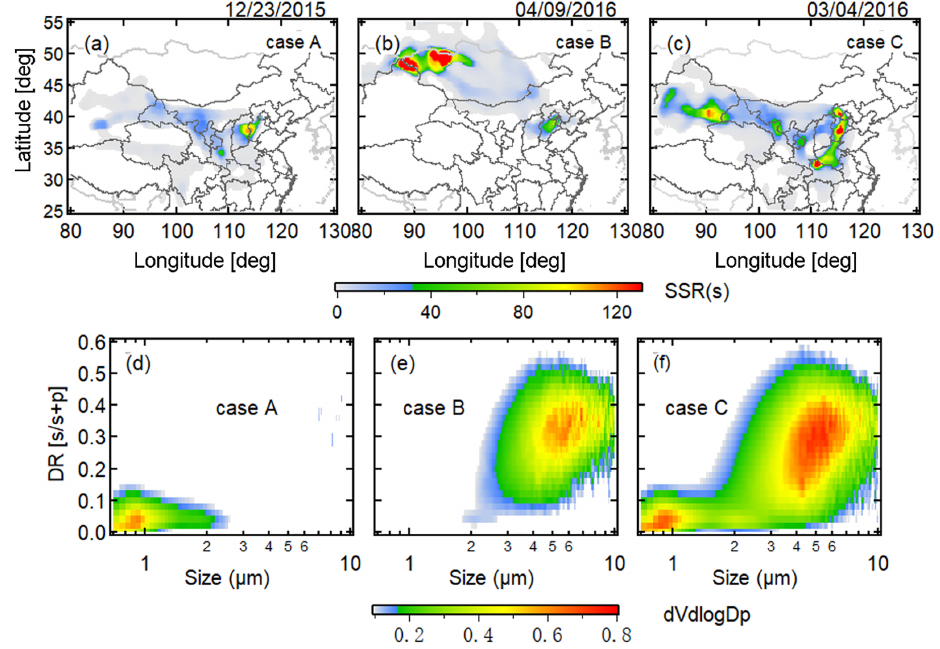
Figure 6. Backward trajectories from Beijing calculated by the FLEXPART dispersion model for (a) the anthropogenic pollution case, (b) the dust-dominant case and (c) the mixed pollution period. Variation in the standard δ value as a function of particle size is shown for corresponding episodes: (d) , (e) and (f)